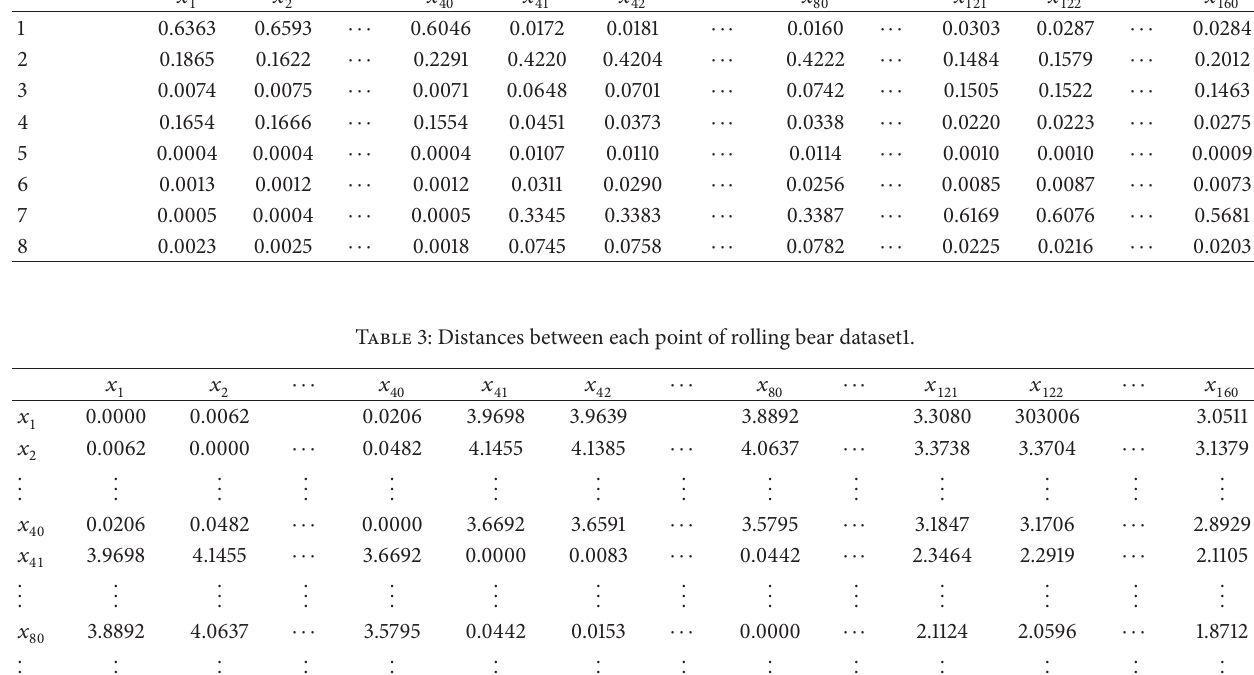
Table 4: Comparison of within-class distance of low dimension using four dimensionality reduction methods. Normal